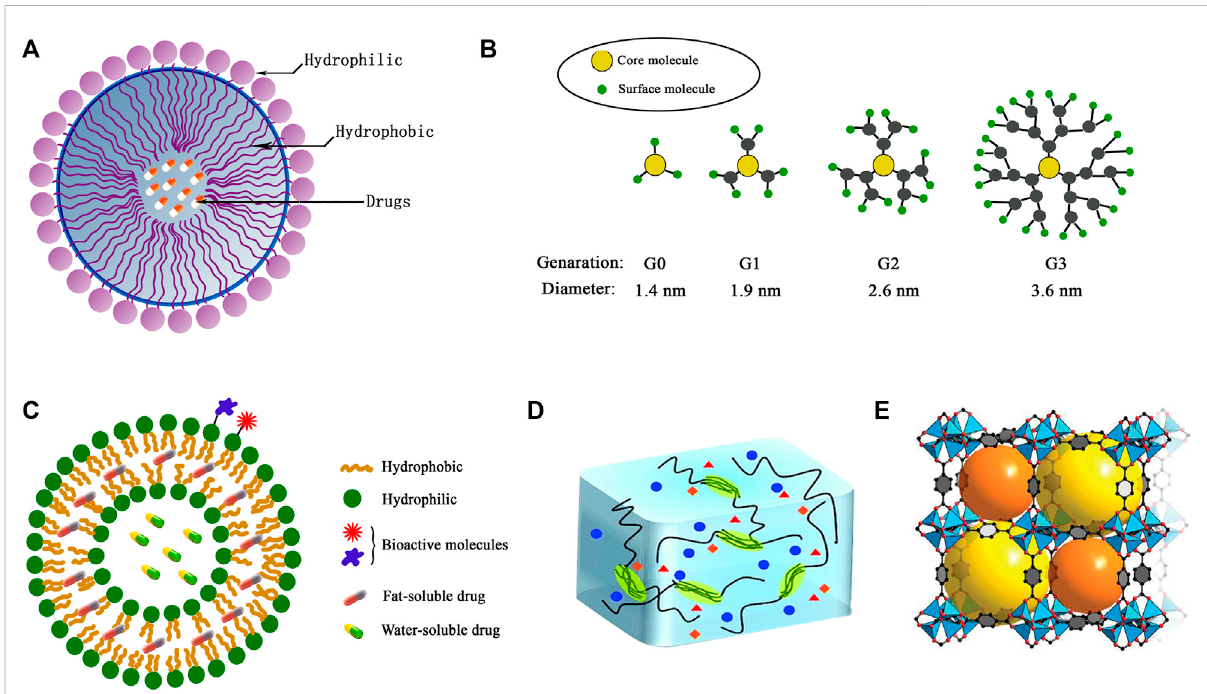
FIGURE 1 The structures of typical polymeric nanoparticles: (A) micelles, (B) dendrimers, (C) polymersomes, (D) hydrogel, (E) metal – organic framework